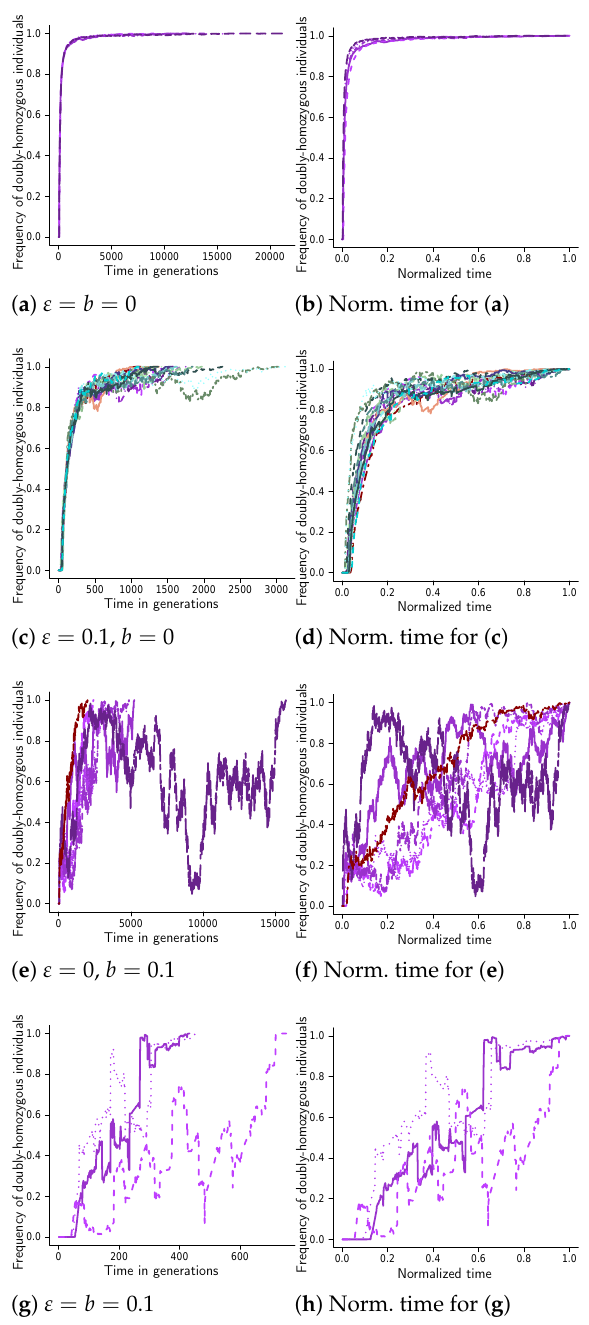
Figure A3. Two sites with weight function as in Equation (A3). Examples of excursions to fixation at two sites with weight function as given by Equation (A3) for carrying capacity C = 10 6 , cutoff u ( N ) = C , probability of recombination r = 0.25 between adjacent sites, α 1 = 0.75, α 2 = 3, ε (see Equation (7)) and probability of a bottleneck b as shown, strength of selection s = 0.1, bottleneck B = 10 3 and results out of ten experiments for ( a ); otherwise 10 2 experiments. Each trajectory traces, as a function of time, the number of diploid individuals homozygous for the fit type at all sites relative to the population size (the number of diploid individuals). The panels on the right ( b , d , f , h ) show the corresponding excursions from the left panels ( a , c , e , g ), where the time to fixation for each excursion is normalized by the time to fixation for the excursion. The scale of the abscissa (time axis) may vary between panels; in each panel, the trajectories were all obtained under identical